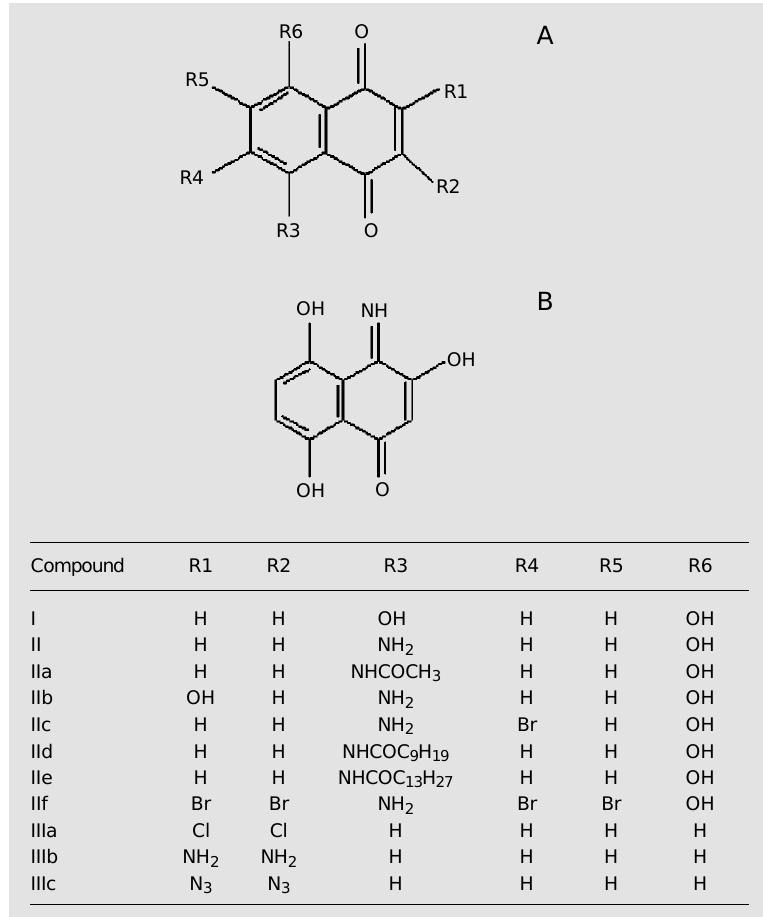
Figure 1. Structures of 1,4-naphthoquinones (A) and a naphthalenone (B) tested in the present study. I = 5,8-dihydroxy-1,4-naphthoquinone; II = 5-amino-8-hydroxy-1,4-naphtho- quinone; IIa = 5-acetamido-8-hydroxy-1,4-naphthoquinone; IIb = 2,8-dihydroxy-5-amino-1,4- naphthoquinone; IIc = 5-amino-6-bromo-8-hydroxy-1,4-naphthoquinone; IId = 5- decanoylamino-8-hydroxy-1,4-naphthoquinone; IIe = 5-tetradecanoylamino-8-hydroxy-1,4- naphthoquinone; IIf = 2,3,6,7-tetrabromo-5-amino-8-hydroxy-1,4-naphthoquinone; IIIa = 2,3- dichloro-1,4-naphthoquinone; IIIb = 2,3-diamino-1,4-naphthoquinone; IIIc = 2,3-diazide-1,4- naphthoquinone. B , Compound IV